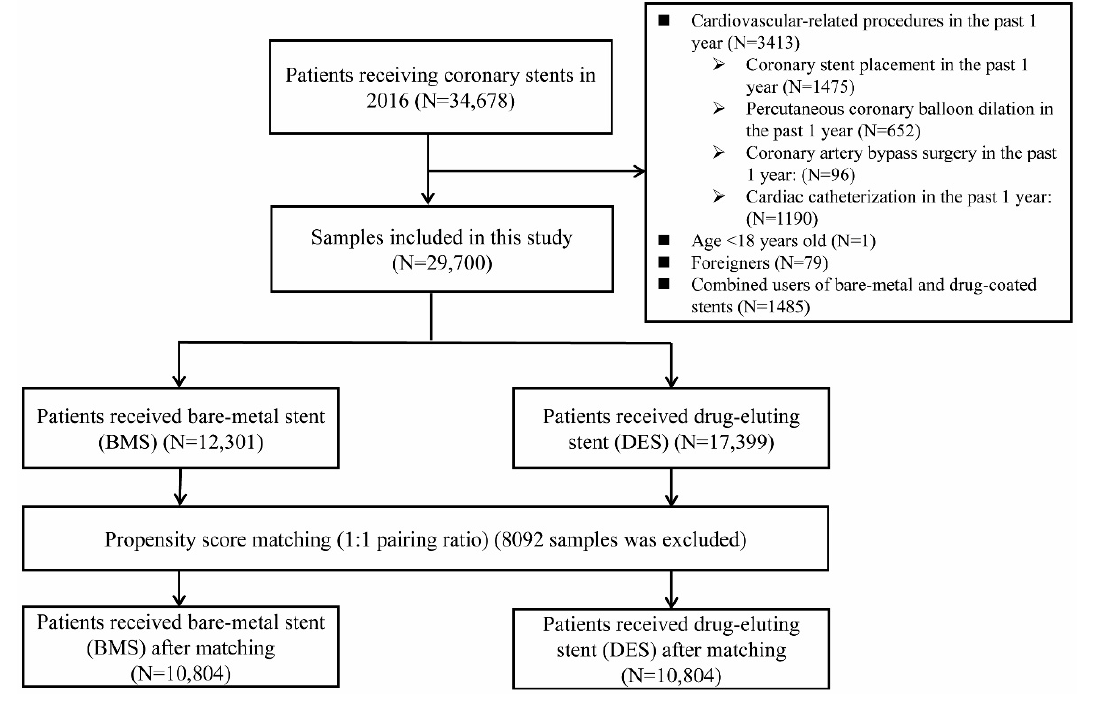
Figure 1. Cohort selection